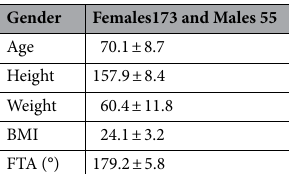
Table 1. Patients characteristics. Mean ± SD. BMI body mass index, FTA femorotibial angle.